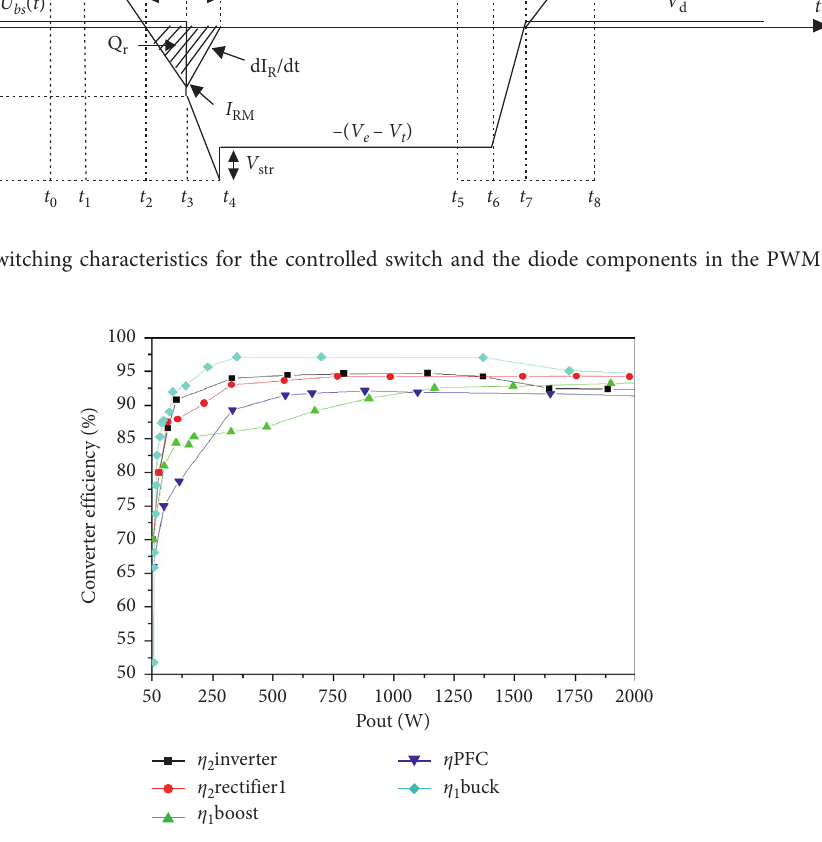
Figure 8: Different converters